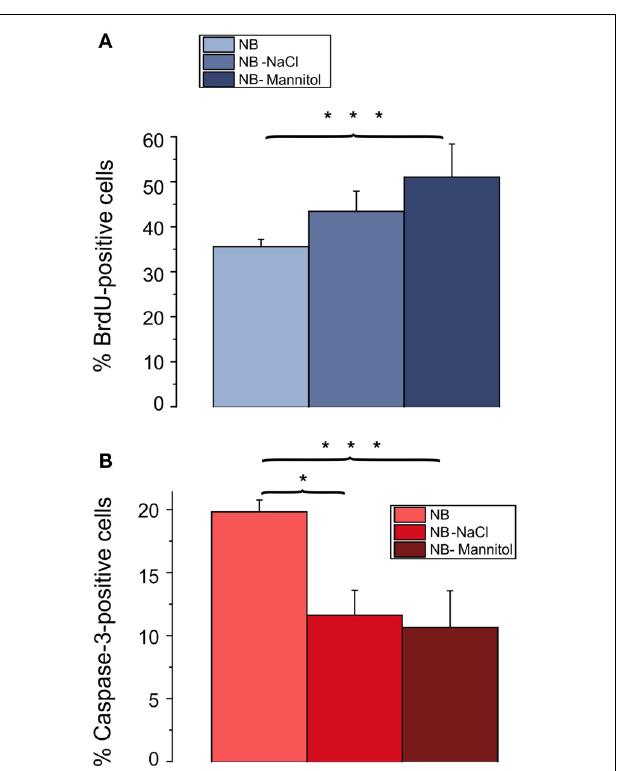
FIGURE 5 | Effects of osmolarity on percentage of BrdU and caspase-3 positive cells. Oligodendrocytes maintained for 3 days in NB based culture that had been supplemented with 52.5mM NaCl or 100mM mannitol to increase the osmolarity of NB to the osmolarity of DMEM. Note, that a change in osmolarity by either mannitol or NaCl results in an increase in proliferating, BrdU positive cells (A) and a decrease in caspase-3 positive, proapoptotic cells (B) (4 coverslips from 4 preparations counted, ∗ p < 0 . 05, ∗∗∗ p < 0 . 005; error bars indicate ± s.e.m., One-Way ANOVA followed by Tukey post-hoc